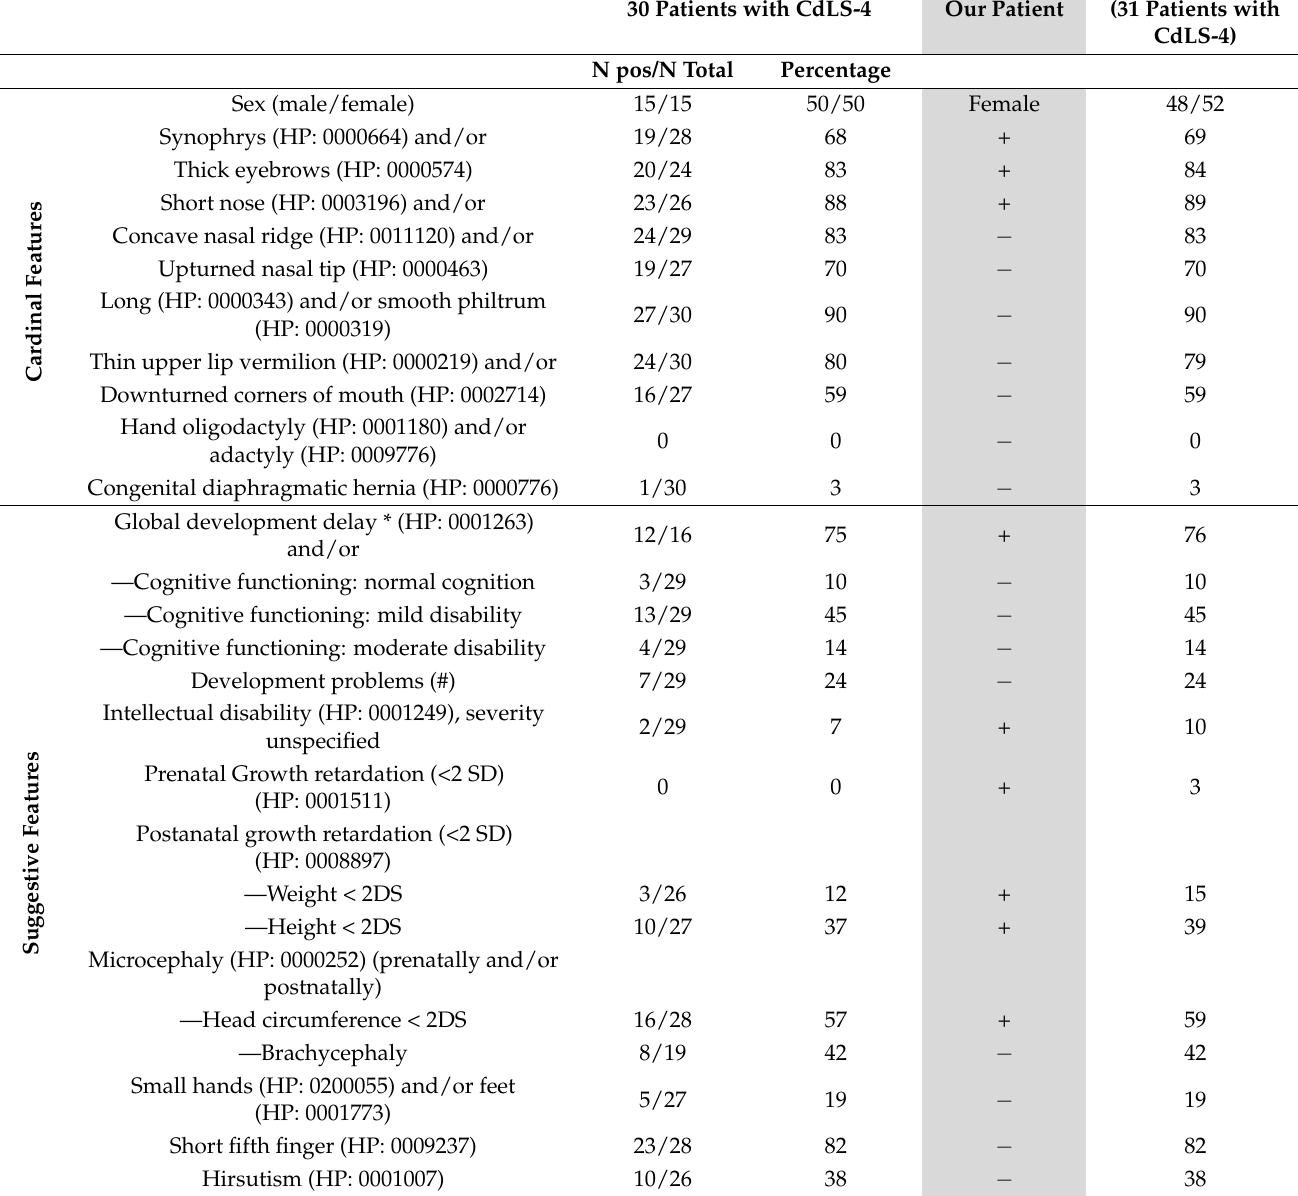
Table 3. Clinical characteristics of affected individuals with RAD21 mutations compared to our index patient (grey column) and recalculation of the new percentages of the features of CdLS type 4 (CdLS-4). “+” stands for clinical features of CdLS-4 present in our patients while “ − ” stands for clinical features of CdLS-4 not present in our